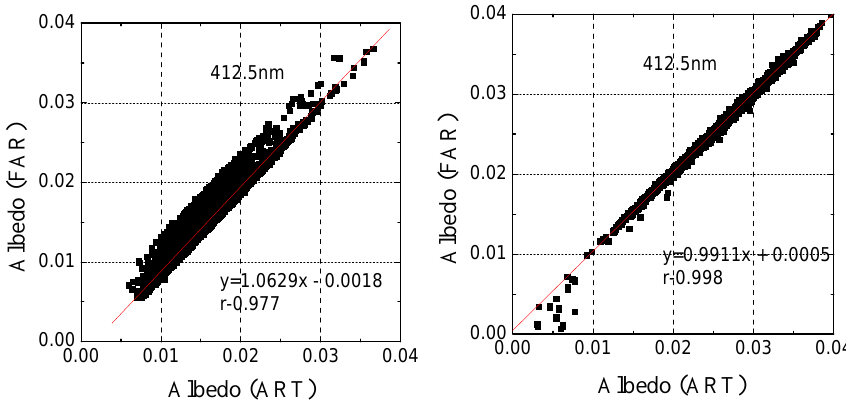
Fig. 17. Correlation by the ART and FAR retrieved albedo of land at 412.5nm for clear (left) and turbid (right) atmospheres (see Fig. 10).